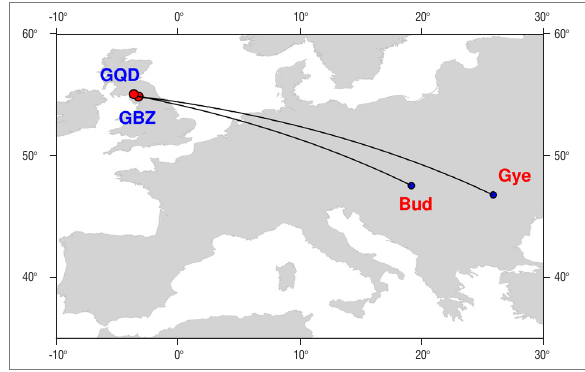
Transmission paths from GQD and GBZ transmitters to receivers at Budapest (Bud) in Hungary and Gyergyóújfalu (Gye) in Romania. Analysis and results There were 21 solar flares with classes greater than C1 detected by the GOES satellites during the period from 14 July 2007 to 17 May 2008. Of these flares, 14 occurred on the illuminated portion of the transmission paths considered in this study. Only five of these flares produced signatures which were evident in the VLF data. The remainder of the flares occurred where the data were either too noisy or, in most cases, during the passage of the solar terminator across the transmission path. The most intense flare occurred on 13 December 2007, which was close to solar minimum, and is classified as a C4.5 with a peak flux of 4.5 µW/ m 2 . The flare started at 09:39 UTC and ended at 10:09 UTC; its peak intensity occurred at 10:03 UTC. The flare was observed by GOES in both the 0.05–0.4 nm and 0.1–0.8 nm X-ray bands (Figure 3). The X-ray